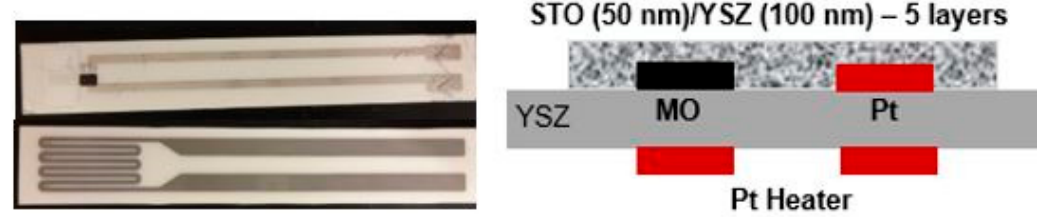
Figure 1. Mixed-potential sensing device and its cross-section image. ( Left ) Front and rear of the sensor showing the electrodes (Mo, Pt, and YSZ/STO electrolyte) and the Pt heater; ( Right ) Cross-section image showing the electrolyte embedding the electrodes.